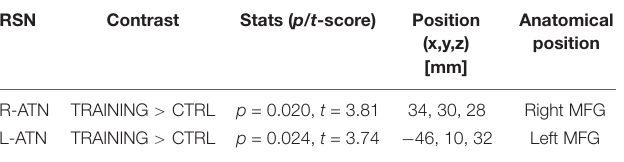
Anatomical (x,y,z) position [mm]